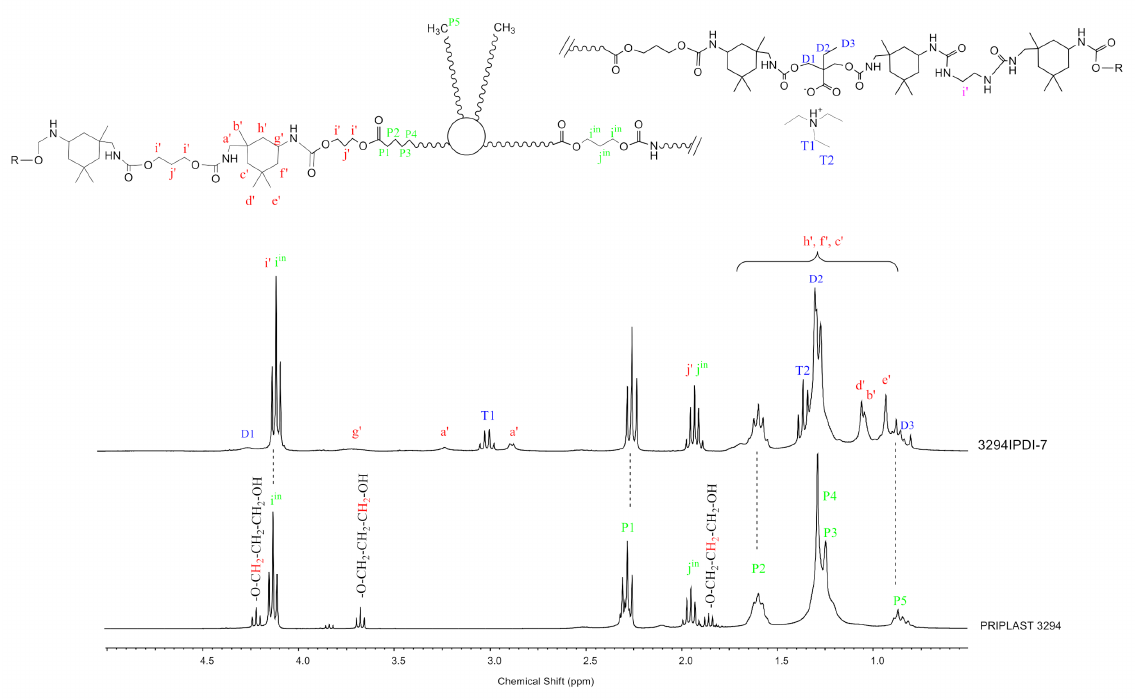
Figure 7. 1 H NMR of experiment 3294IPDI-7 and starting polyol Priplast 3294 with peak assignments. 1 H NMR spectra provided structural information regarding Priplast 3294 polyol